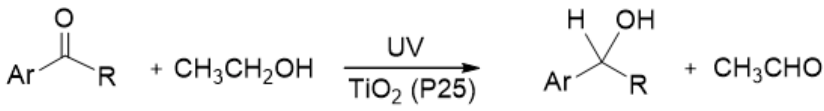
Scheme 1. Photocatalytic hydrogenation of aromatic carbonyl compounds: Ar = aromatic ring, R =